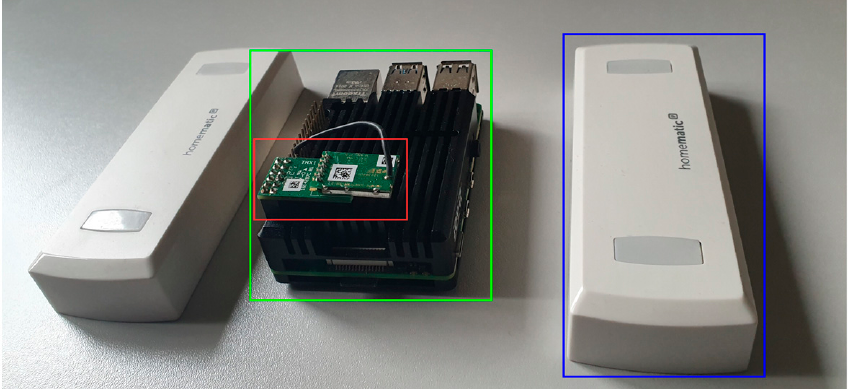
Figure 4. Used hardware in our test setup: Raspberry Pi4 (green), Homematic radio module (red), passage sensors (blue).